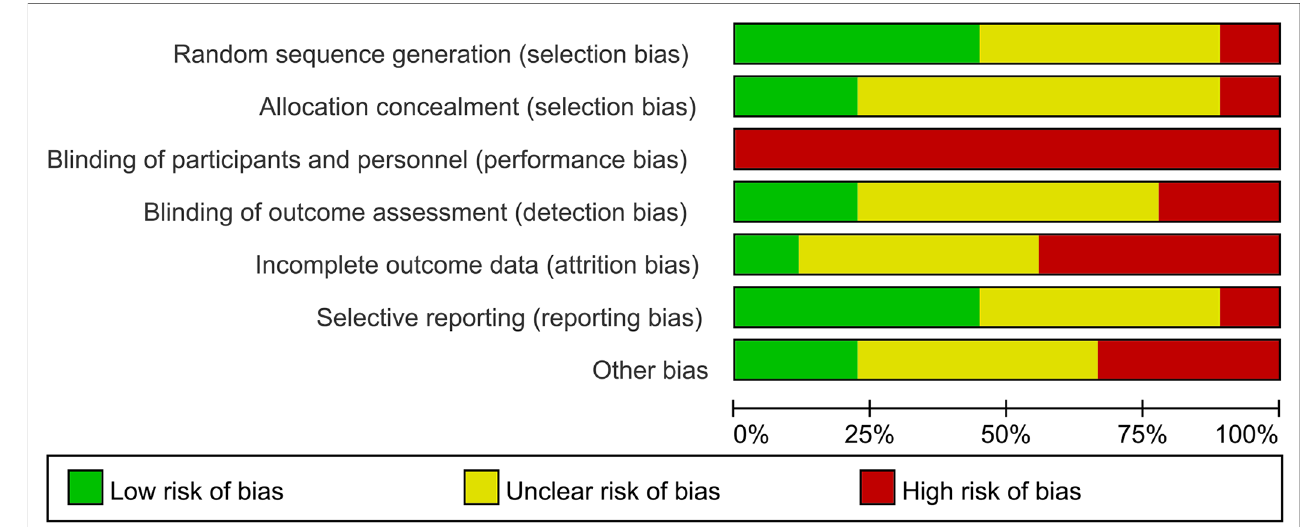
Fig 2. Risk of bias graph.